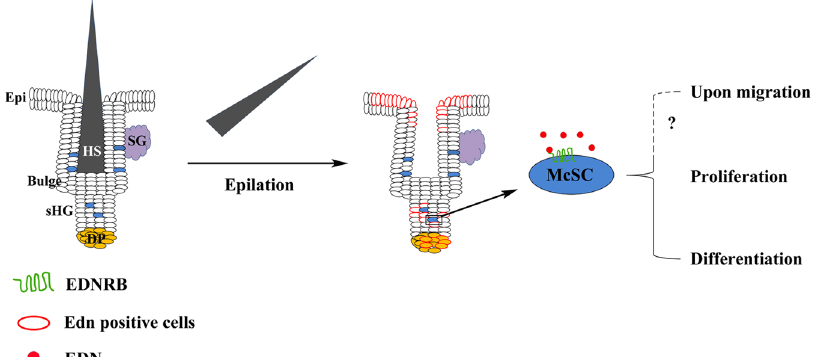
Figure 6. Schematic illustration of the role of EDN/EDNRB signaling in epilation-induced skin and hair pigmentation. After epilation, expression of EDNs is increased in epidermis, secondary hair germ and dermal papilla. McSCs respond to the increased EDNs secreted from surrounding cells, resulting in activation of the EDNRB signaling pathway. As a result, McSCs proliferate, likely migrate along the hair follicles into epidermis and differentiate into mature melanocytes for melanogenesis. Epi, epidermis; DP, dermal papilla; HS, hair shaft; sHG, secondary hair